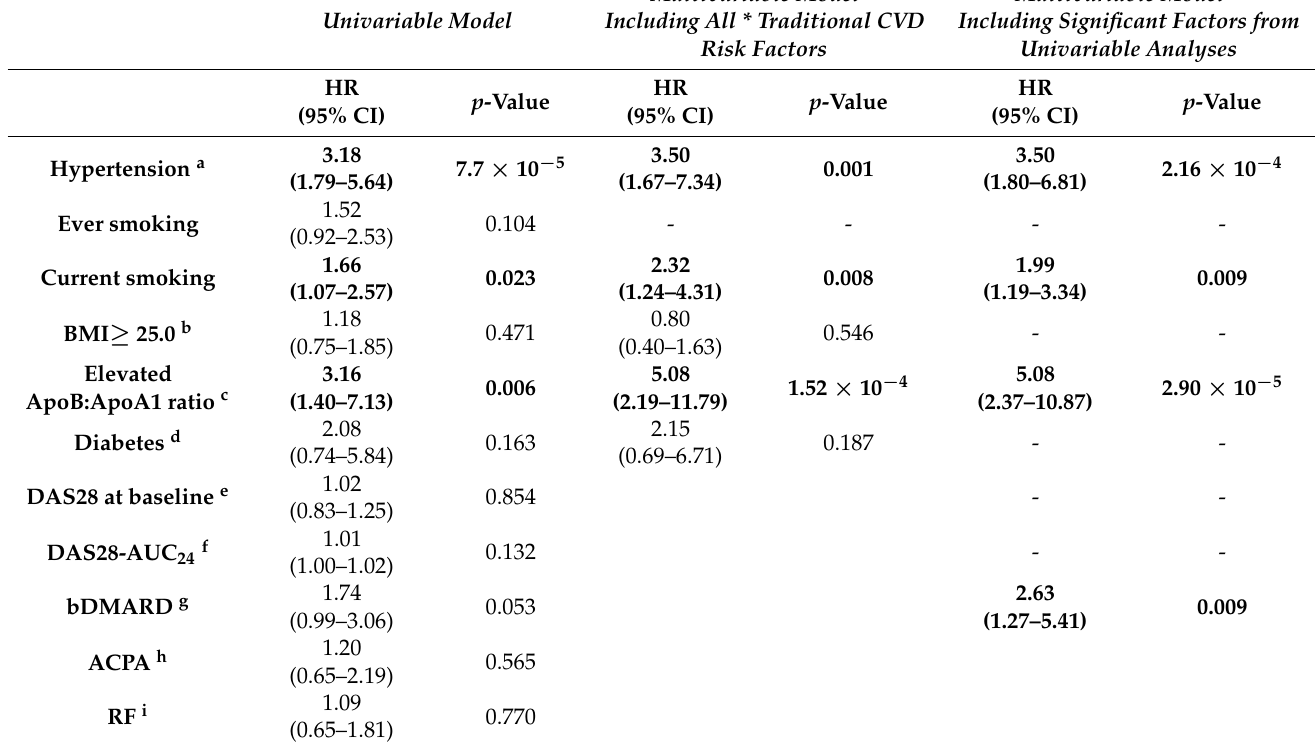
Hazard ratios with 95% confidence intervals (HR, 95% CI) for cardiovascular events after the 1 index date (time point of diagnosis of RA), adjusted for age and sex. a Hypertension (systolic blood pressure (SBP) ≥ 140 mmHg and/or diastolic blood pressure (DBP) ≥ 90 mmHg, including hypertensive treatment), adjusted for